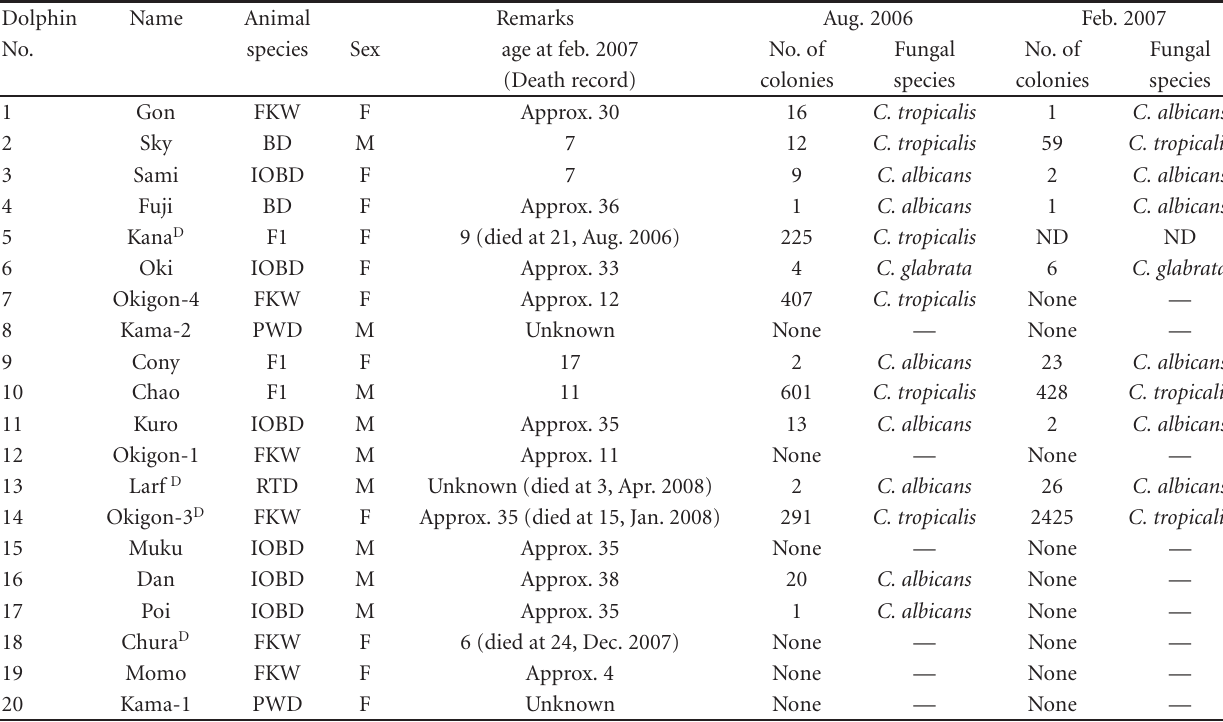
Table 2: Dolphins and pathogenic yeasts